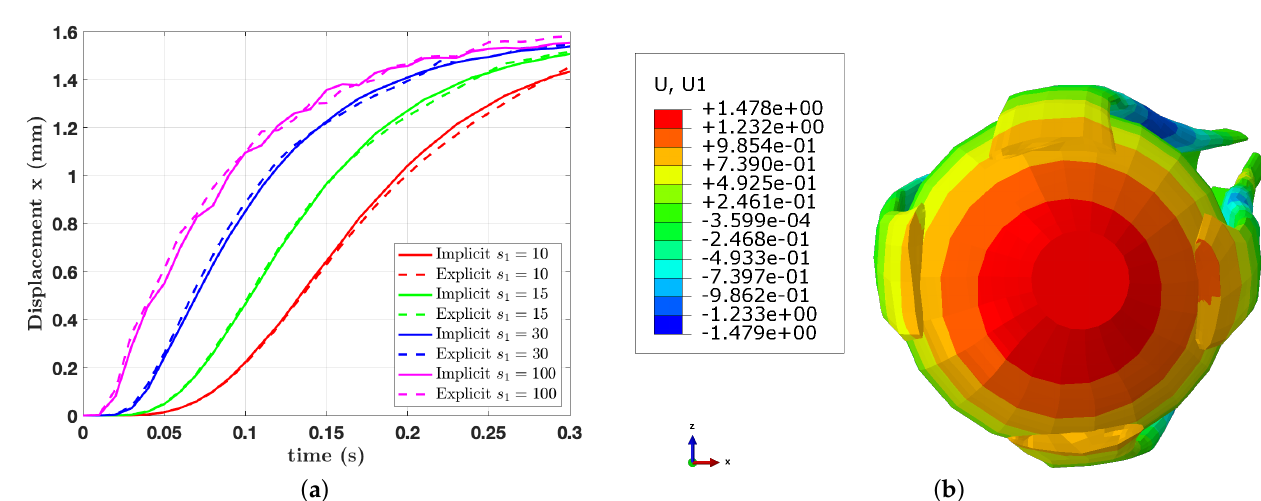
Figure 6. ( a ) Evolution of the displacement of a node located at the center of the surface of the mesh where the pupil is located for all the activation signals considered using both algorithms; and ( b ) displacement field in the x direction for an implicit simulation with s 1 = 10 at t = 0.3 s.